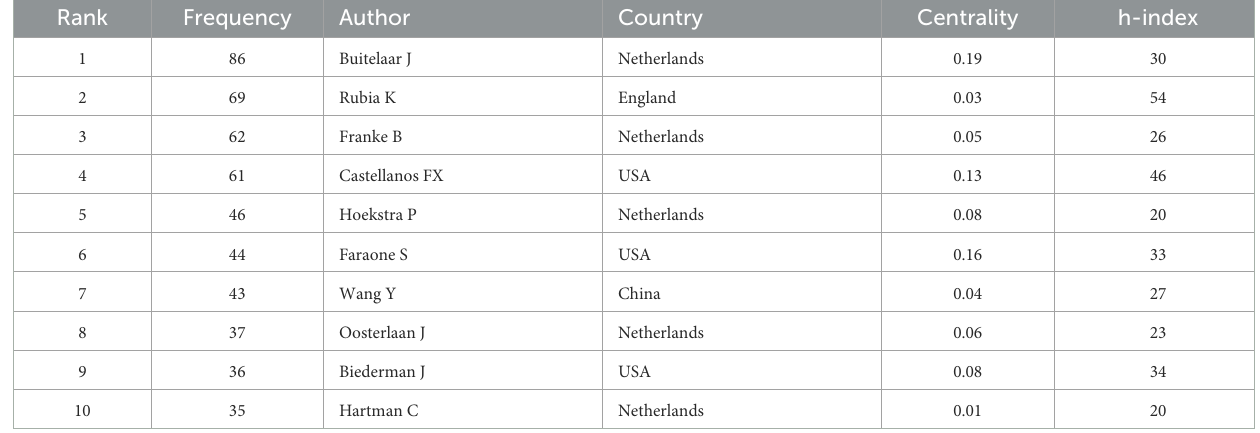
TABLE 3 Top 10 frequency and centrality of authors related to ADHD neuroimaging.